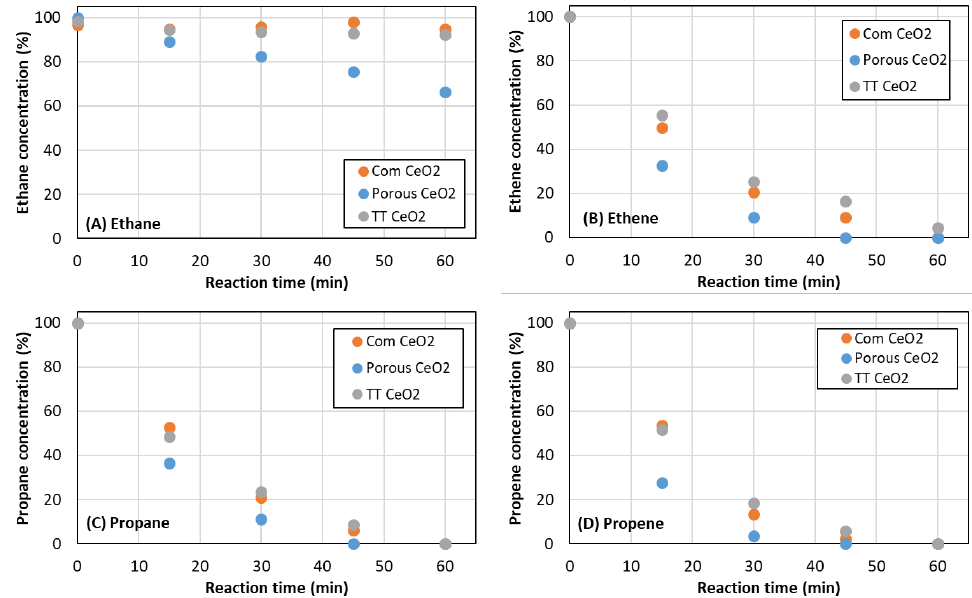
Figure 7. The elimination profile of ( A ) ethane, ( B ) ethene, ( C ) propane, and ( D ) propene over porous, commercial, and thermally treated ceria.